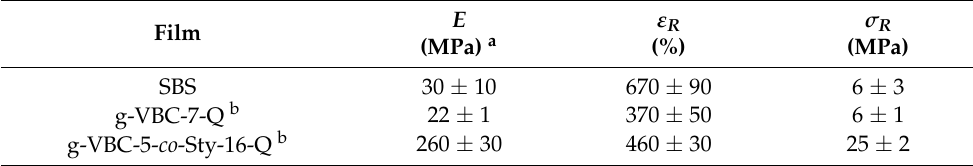
Table 4. Mechanical properties of the aminated membranes and the SBS starting material.